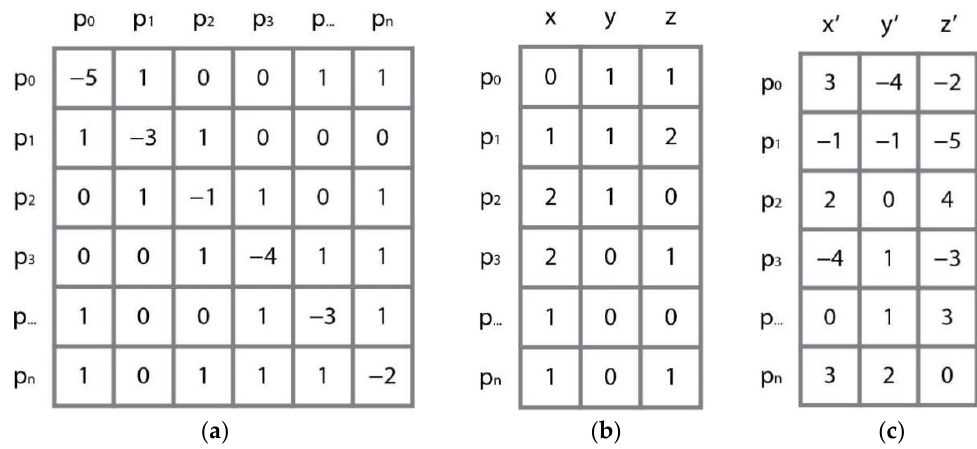
Figure 4. Matrix operations: ( a ) rows of the relative adjacency matrix; ( b ) the coordinate matrix; and ( c ) new feature matrix.